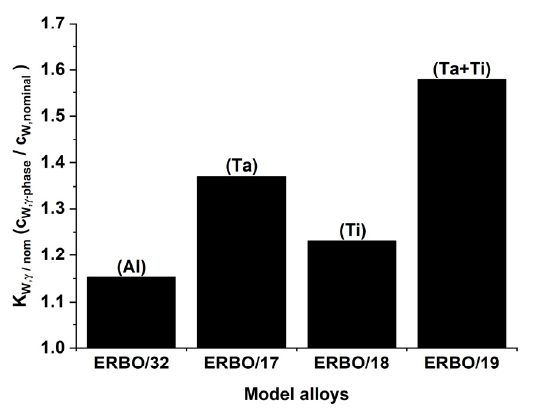
Figure 8. Analysis of the partitioning efficiency W for the single-crystalline model alloy series. The alloying elements Ti and Ta in ERBO/17, ERBO/18 and ERBO/19 replace some of the Al content compared to the base alloy ERBO/32, such that a γ (cid:48) -forming elements sum (Al + Ta + Ti) of 15 at.-% is retained.